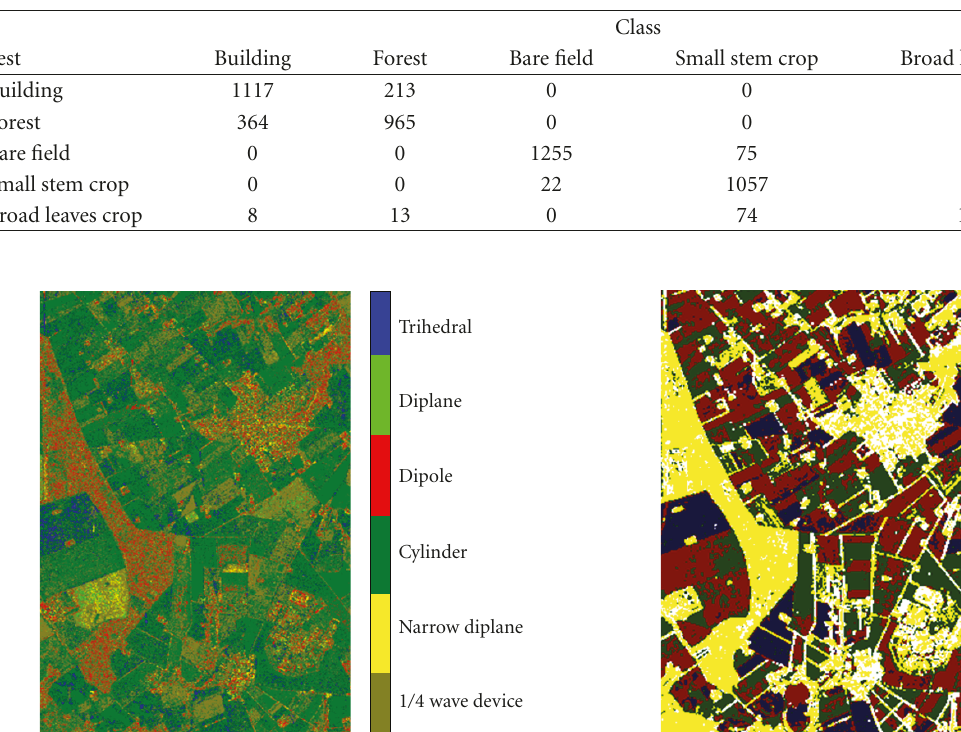
Table 1: The classification result of test pixels.